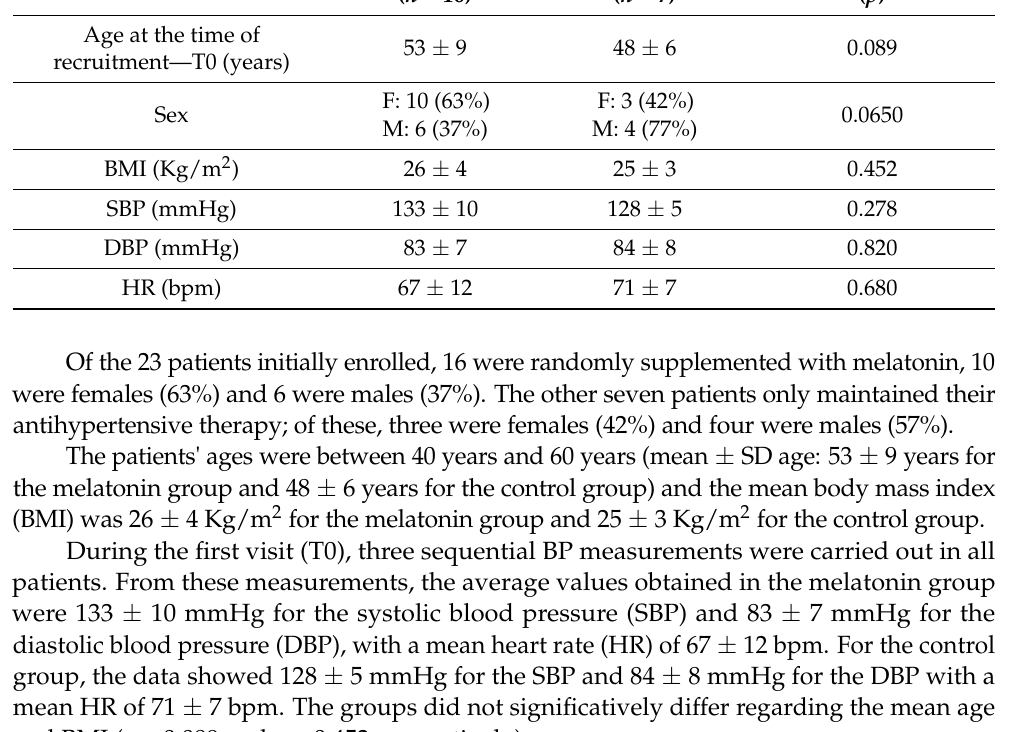
Table 1. Demographic and clinical description of study cohort of patients with essential hypertension (HE) obtained during the first evaluation (T0). Data are expressed as mean ± standard deviation (SD). (BMI: body mass index; SBP: systolic blood pressure; DBP: diastolic blood pressure; HR: heart rate). Characteristics